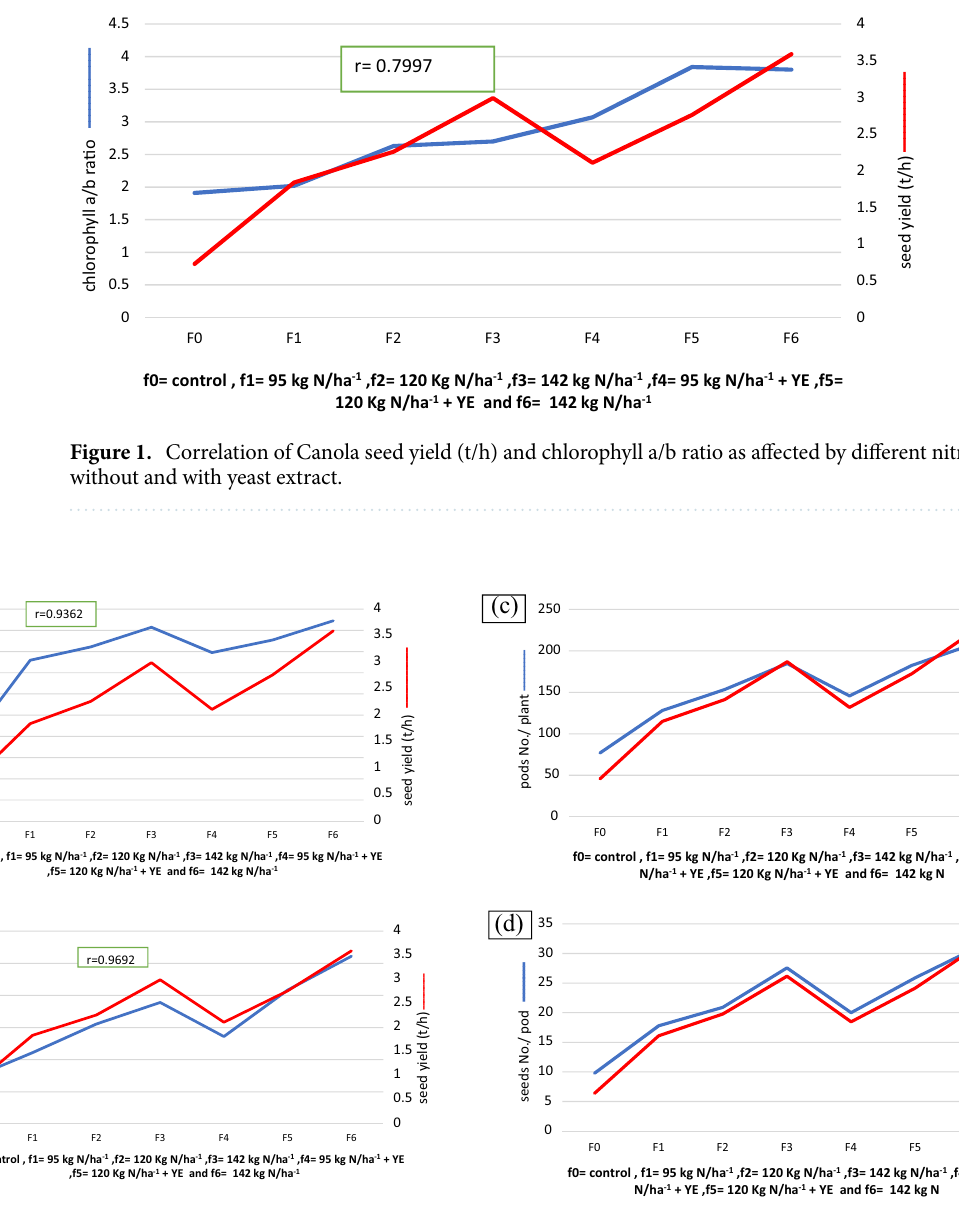
Figure 2. ( a ) Correlation of Canola seed yield (t/h) and plant height (cm) as affected by different nitrogen rates without and with yeast extract, ( b ) Correlation of Canola seed yield (t/h) and branch No/plant as affected by different nitrogen rates without and with yeast extract, ( c ) Correlation of Canola seed yield (t/h) and pods No/ plant as affected by different nitrogen rates without and with yeast extract, and ( d ) Correlation of Canola seed yield (t/h) and seeds No/ pod as affected by different nitrogen rates without and with yeast